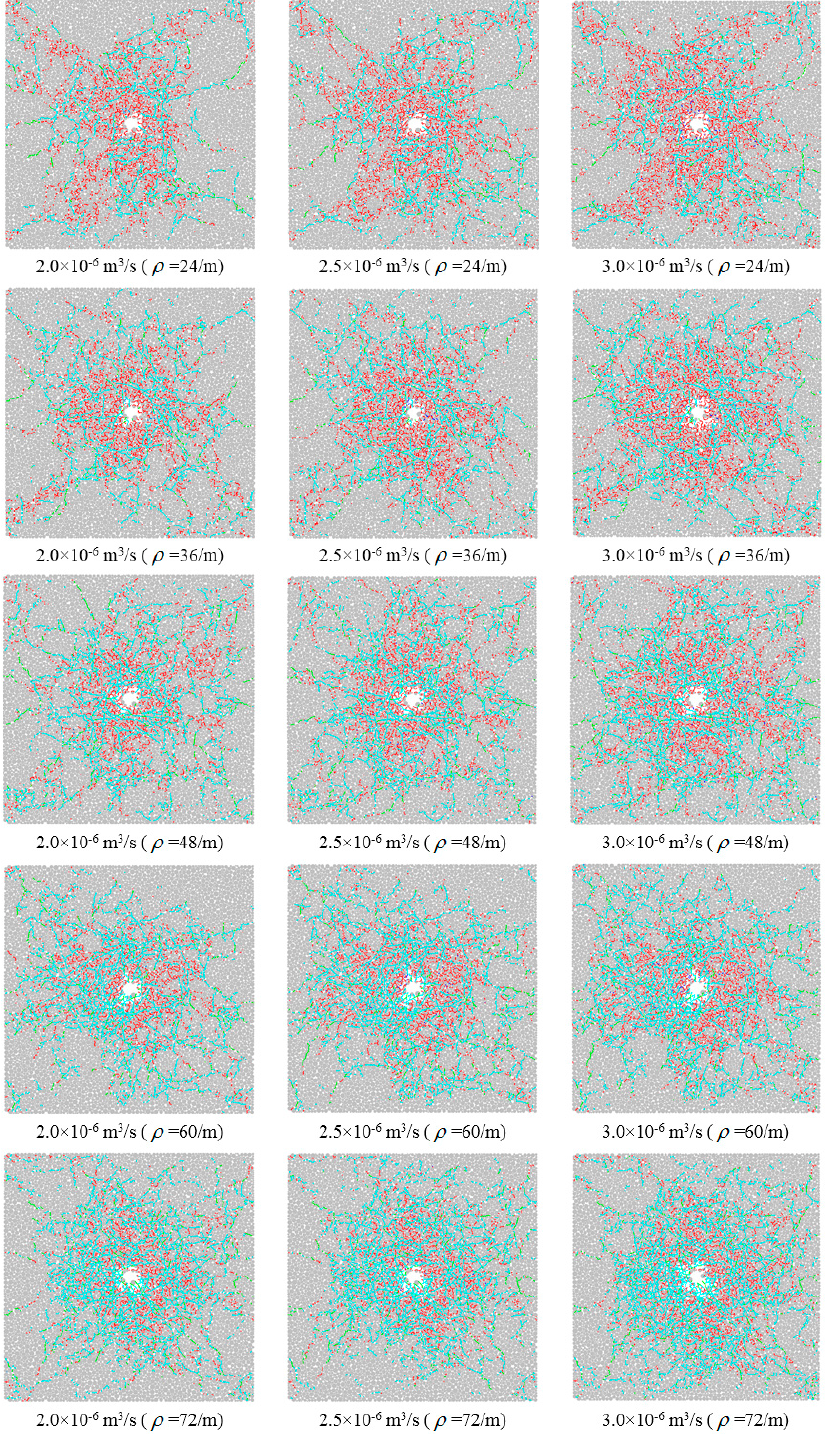
Figure 27. Change of crack distribution with injection rate when NF density ranges from 24/m to 72/m and confining pressure ratio is S H : S h =